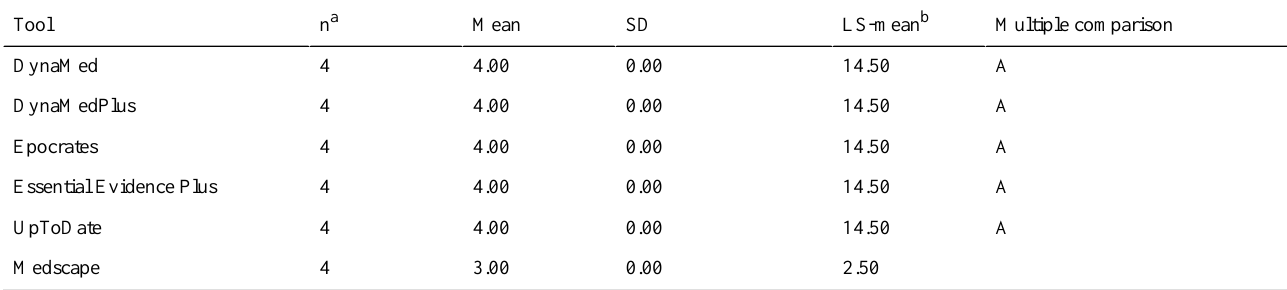
Table 3. Quality among six point-of-care